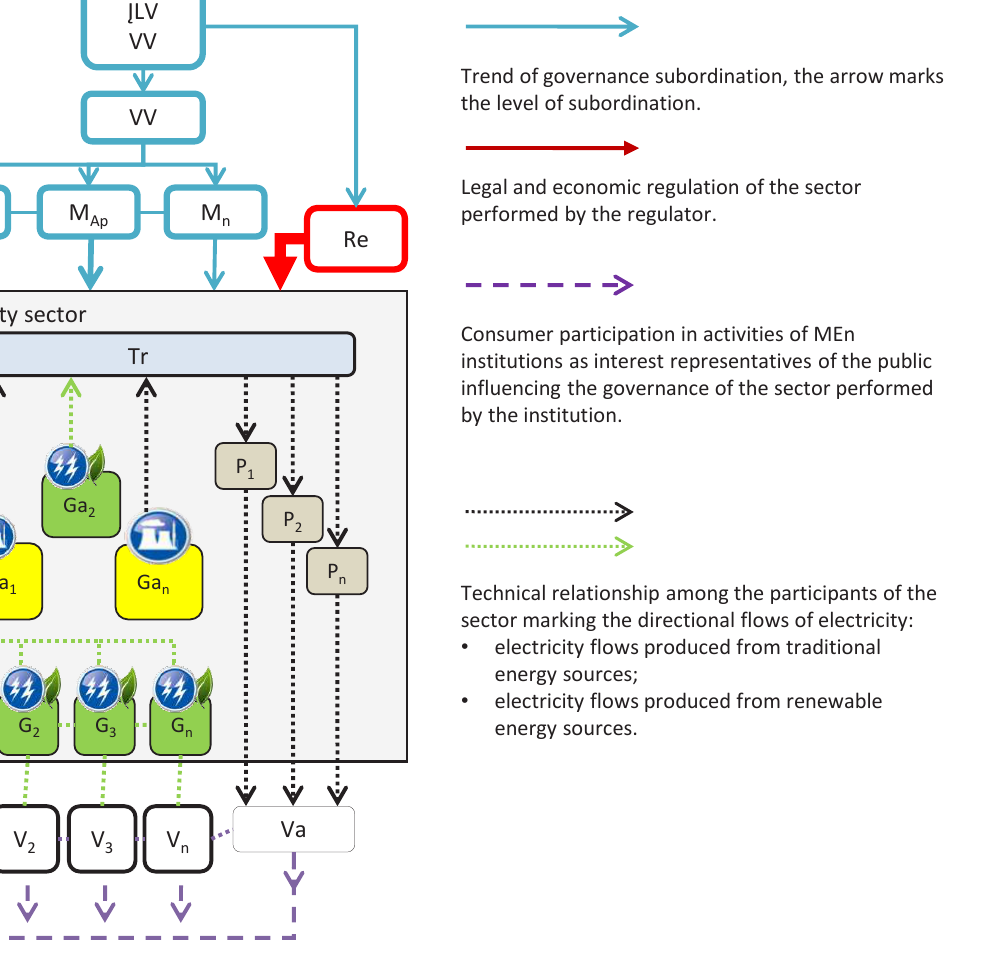
Figure 3. A model for increased citizen participation in the governance of electricity sector in